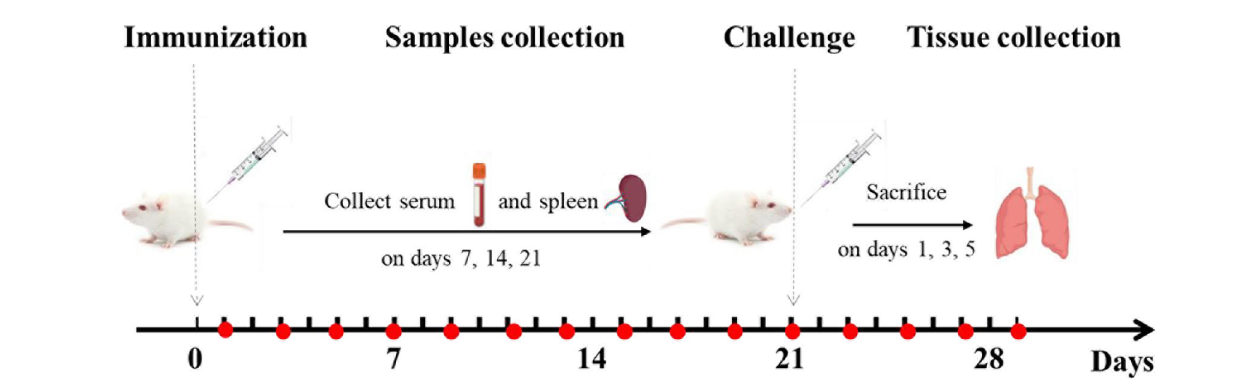
FIGURE 2 | Animal immunization and challenge. Mice were immunized on day 0 and challenged on day 21. Mouse serum was collected for the detection of antibody levels on days 1, 3, 5, 7, 9, 11, 13, 15, 17, 19, 21, 23, 25, 27, and 29 after immunization. The levels of anti-HA (IgG), IgG1, IgG2a, IL-4, and IFN- g were detected on days 7, 14, and 21 after immunization. Mouse spleens were collected to assess lymphocyte proliferation activity, CTL responses, and T cell subsets on days 7, 14, and 21 after immunization. The lungs of mice were collected to detect the lung viral loads and pathological changes on days 1, 3, and 5 after the challenge.